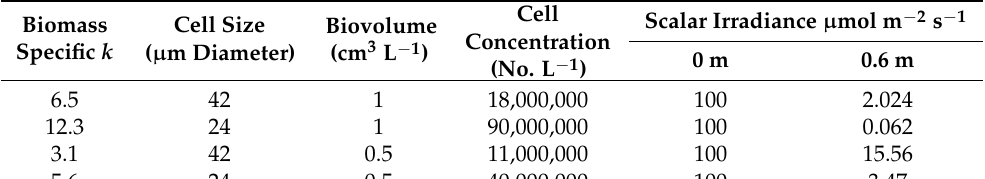
Table 4. Scalar irradiance in the 300 m 3 reactor at different biomass concentrations and cell size, k calculated from n = 62.